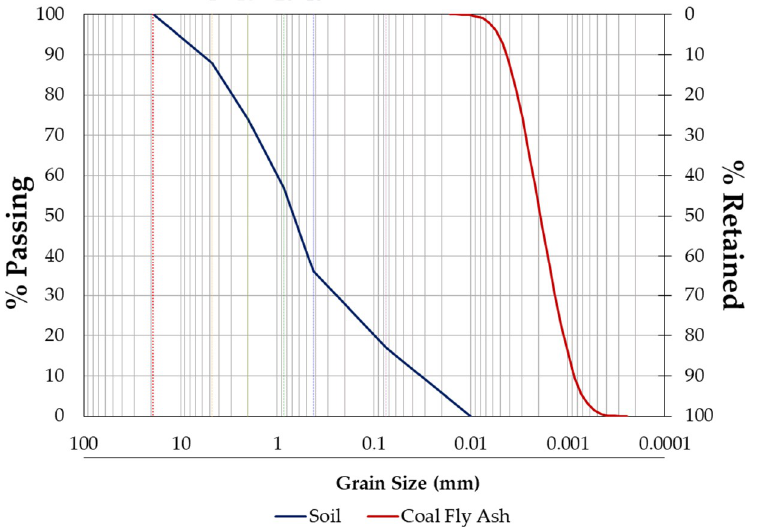
Figure 2. Particle size distribution of soil and coal fly ash [29].